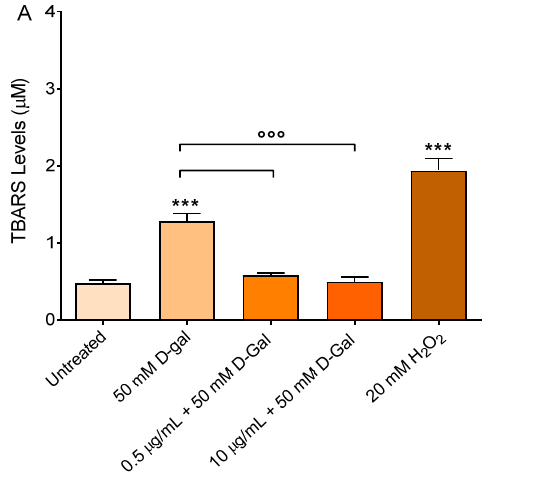
Figure 5. Detection of TBARS levels. TBARS levels (µM) in erythrocytes left untreated (control) or treated for 24 h with 50 ( A ) or 100 mM ( B ) D -Gal, with or without pre-incubation for 1 h with 0.5 or 10 µg/mL freeze-dried Açaì. H 2 O 2 (20 mM, 1 h at 37 °C) was used as the positive control. ***, p < 0.001 versus control; °°° , p < 0.001 versus 50 and 100 mM D -Gal, one-way ANOVA followed by Bonferroni’s post hoc test ( n = 10).